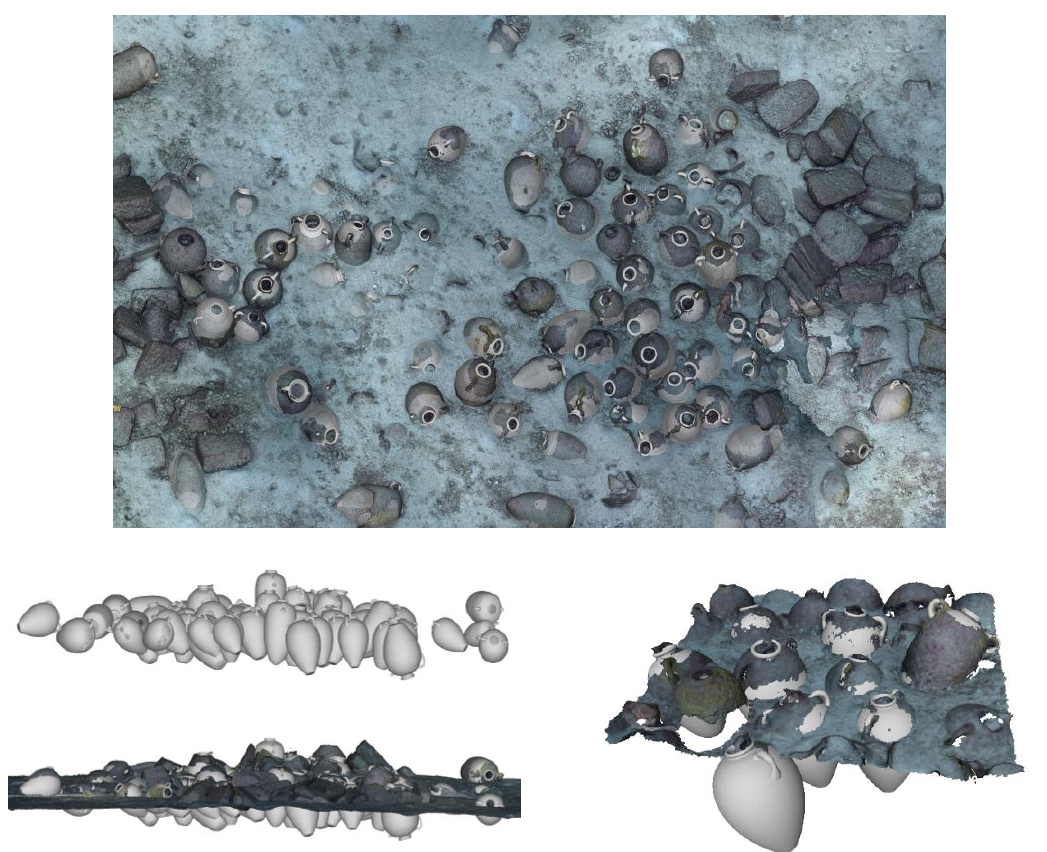
Figure 17. First matching using a manual recognition of the typology.